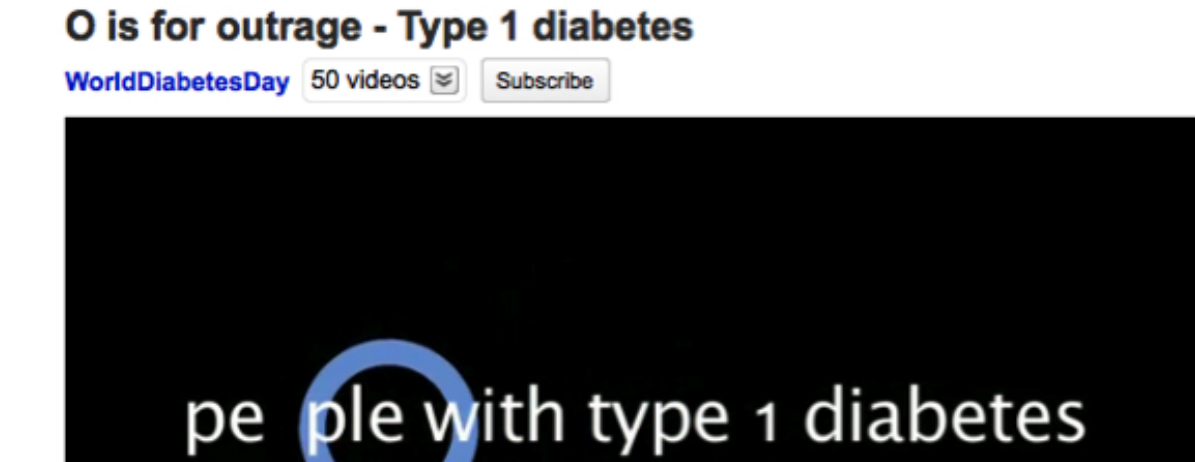
Figure 11. Screenshot from the video O is for outrage – Type 1 diabetes